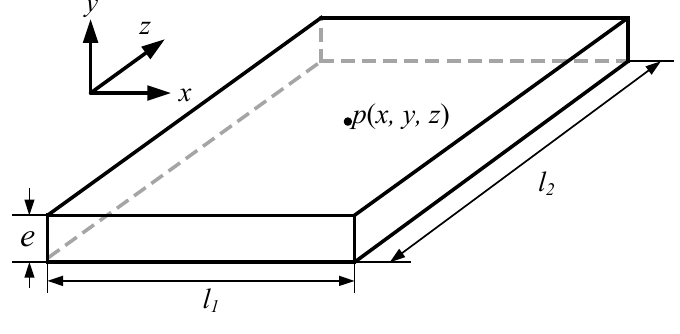
Figure 2. Thin‐layer element. Figure 2. Thin-layer